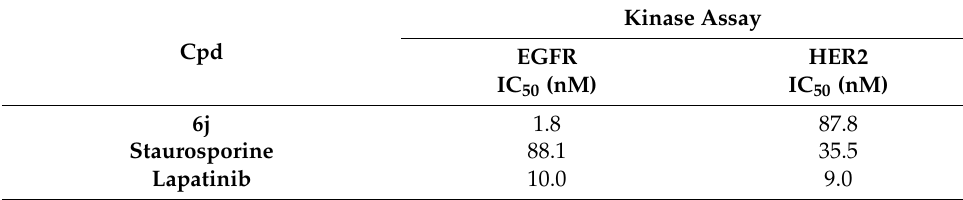
Table 4. IC 50 values ( µ M) exhibited by compound 6j and staurosporine on EGFR and